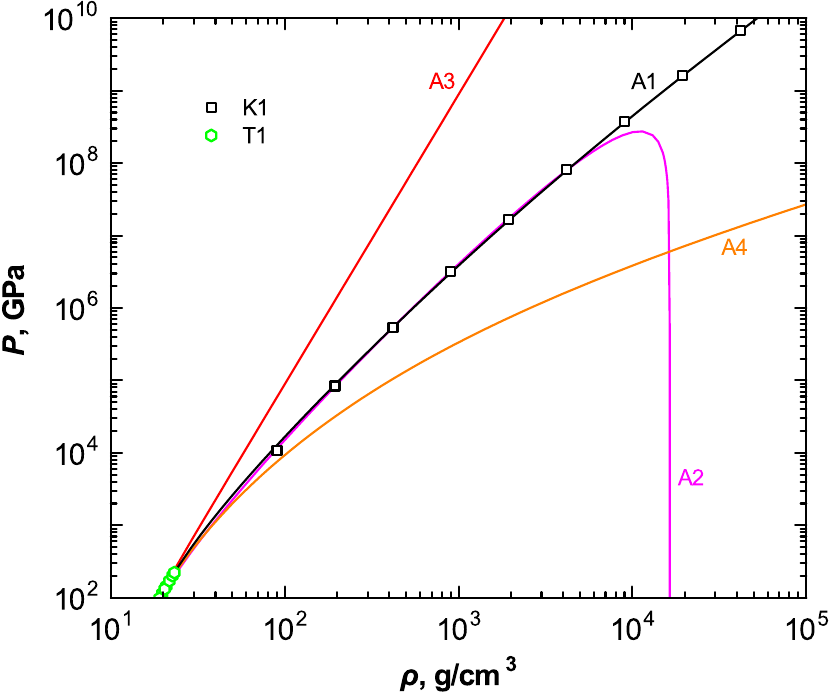
Figure 1. Pressure on the isotherm T = 0 as a function of density: A1—calculation results according to the present model; A2—approximation [34,39]; A3—approximation [40]; A4—approximation [38]; K1—results of calculations using the Thomas–Fermi model with corrections [44,45]; T1—experimental data at room temperature